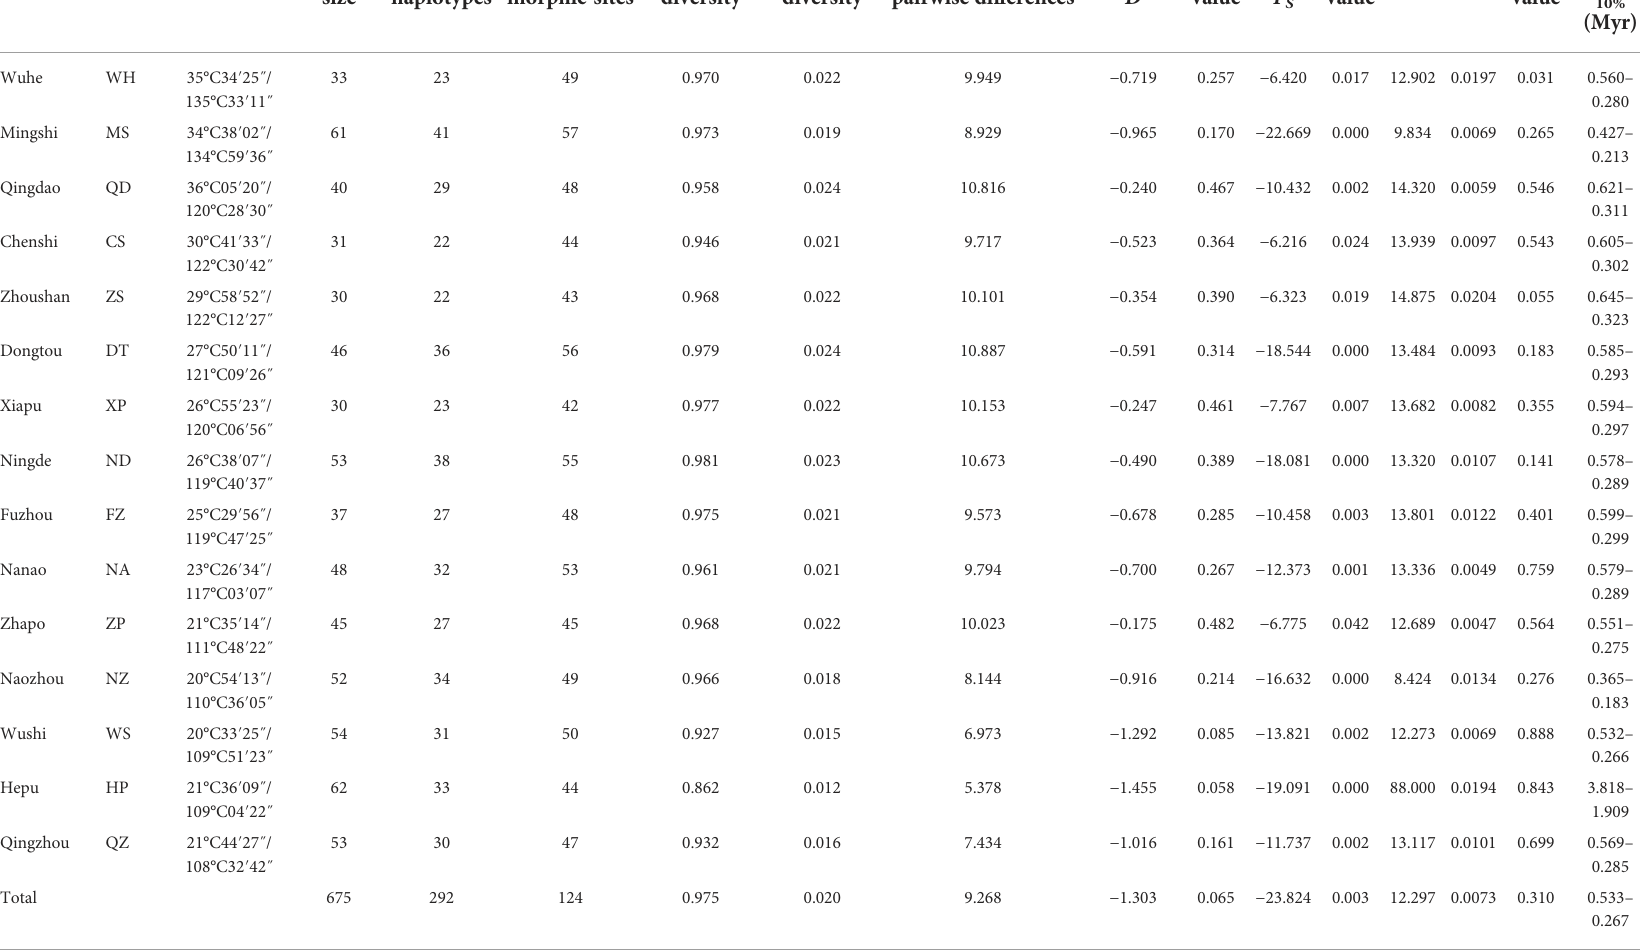
TABLE 1 Sampling locations, sample size, genetic diversity, and neutrality